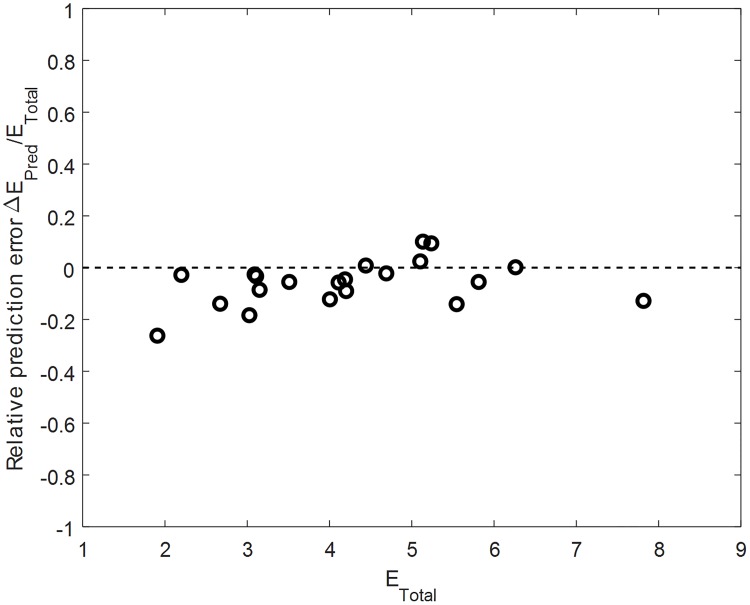
Prediction error of energetic collision loss for rotational hopping strategy.The off-centred mass wheel was thrown over the obstacle, and the touchdown position and velocity state was used to predict theoretical loss ΔETheor, which was compared to the experimental loss ΔEExp to give the prediction error ΔEPred. The value is normalized with the total energy at touchdown ΔETotal = ΔEKin + ΔEPot.